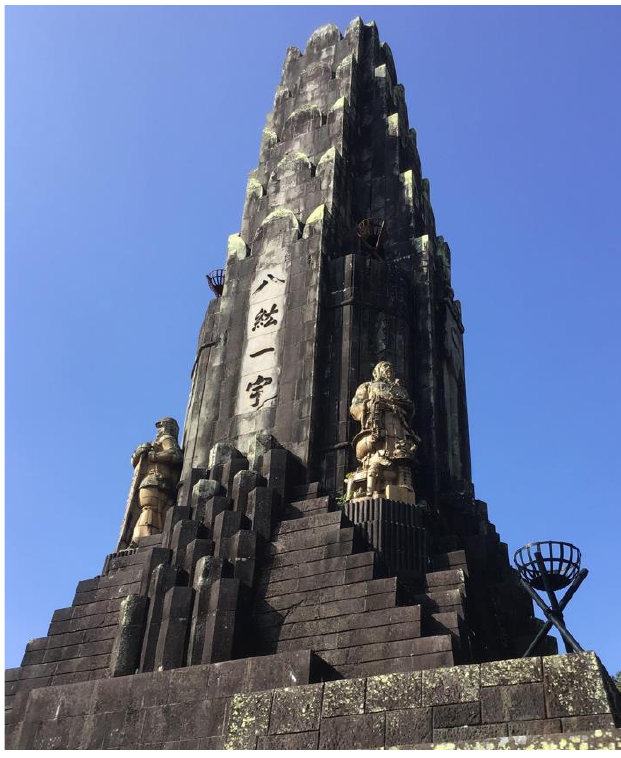
Figure 2. Hakkō Ichiu Tower, Miyazaki, Japan. ©️ Hatena Blog. 2022.